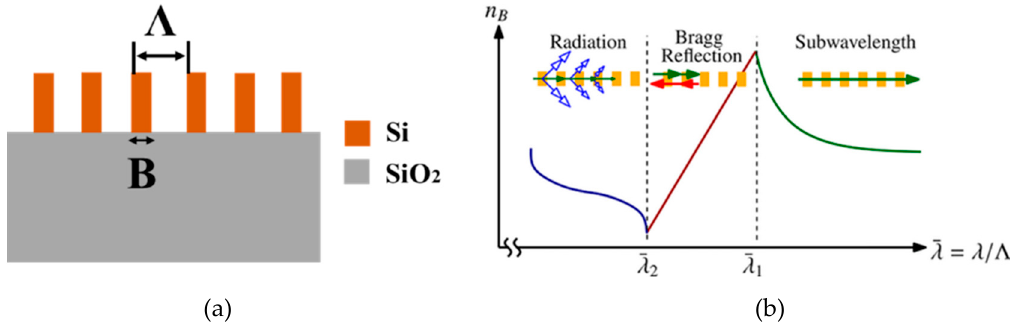
Figure 7. ( a ) Schematic of subwavelength gratings; ( b ) the relationship between effective index and wavelength-to-pitch ratio. Reproduced with permission from [71], Copyright John Wiley and Sons, 2014.